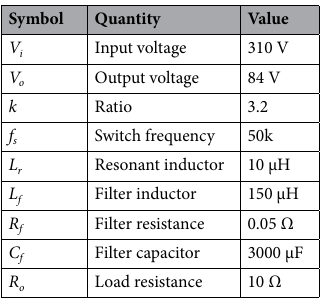
Table 1. Parameters of components in circuit.